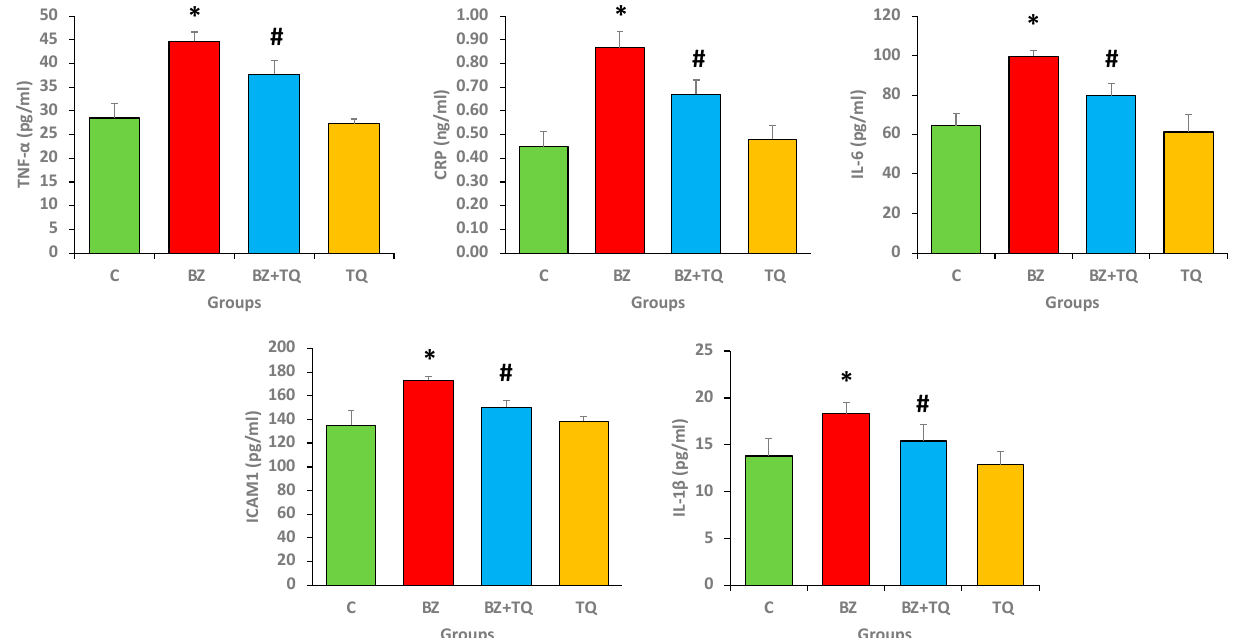
Figure 5. Inflammatory marker levels were significantly increased in animals intoxicated with B(a)P compared to the control group. B(a)P plus TQ treatment significantly decreased these inflammatory marker levels. The graphs represent the mean ± SEM, with 8 rats/group. The numbers signify the mean ± SEM, with 8 rats/group. The statistical differences are denoted with as asterisk (*), indicating significance at p < 0.05 in comparison with the control group, and a hashtag (#), signifying p < 0.05 in comparison with the disease control.